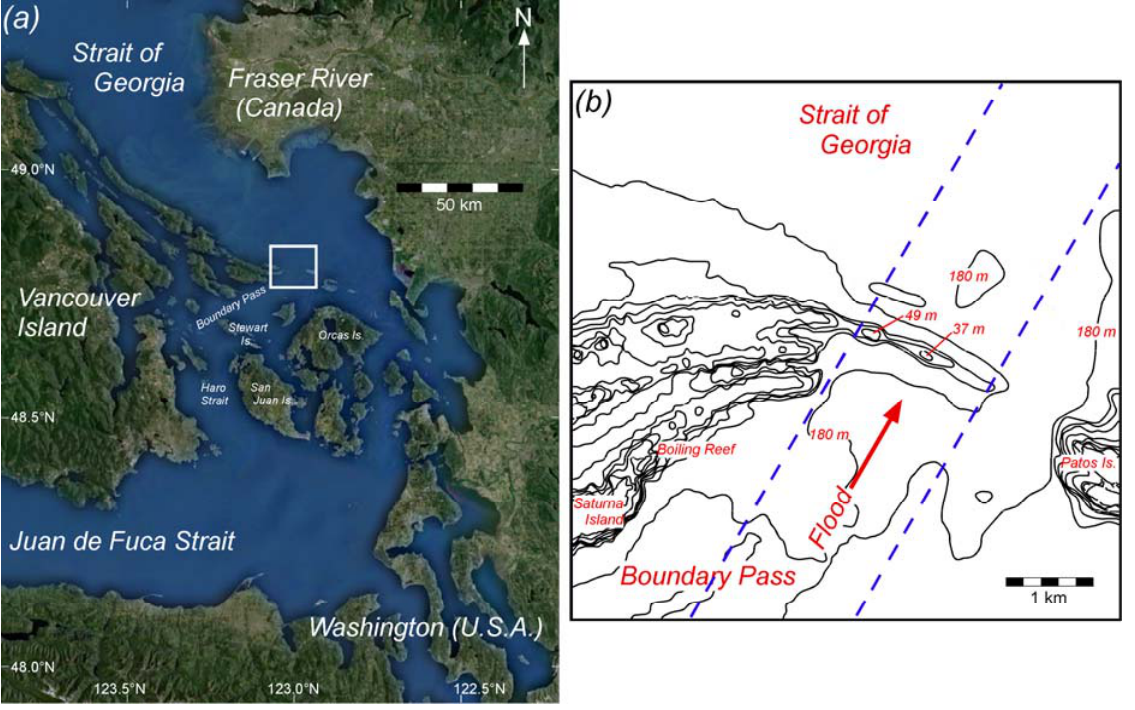
Figure 1. ( a ) Location of study area (white rectangle); ( b ) Bathymetry in study area. Blue lines enclose area sampled by aircraft flights. Arrow indicates the direction of the current during flood tide.